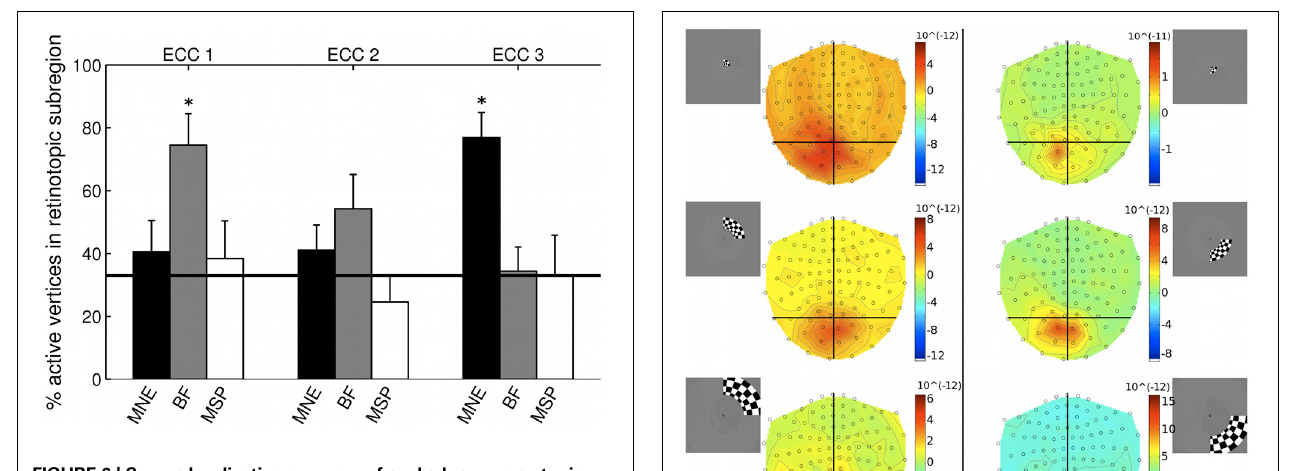
FIGURE 6 | Source localization accuracy of evoked responses to ring stimuli, reconstructed with MNE (black), beamformer (BF, gray), and MSP (white). Bars show percentage of active vertices localized to the fMRI-defined eccentricity band across visual areas V1, V2, and V3 for each stimulus eccentricity (ECC 1, ECC 2, ECC 3). Error bars show s.e.m. Black line indicates chance accuracy level (33%). ∗ indicates p m < 0 . 0056 for Table 3 | Localization accuracy for eccentricity mapping.